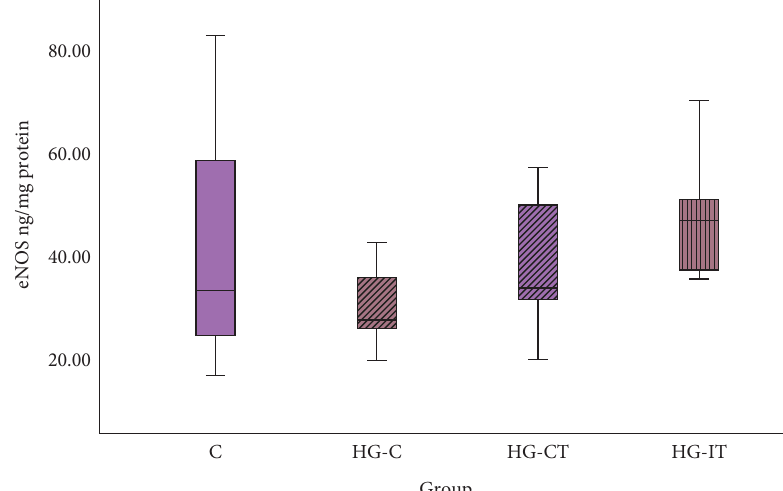
Figure 3: eNOS concentration within each group. c: control group; HG-C: hyperglycemic control group; HG-CT : hyperglycemic rats that performed moderate-intensity continuous training (MICT); HG-IT: hyperglycemic rats that performed high-intensity interval training (HIIT). Te error bars represent the standard deviation of measurements.